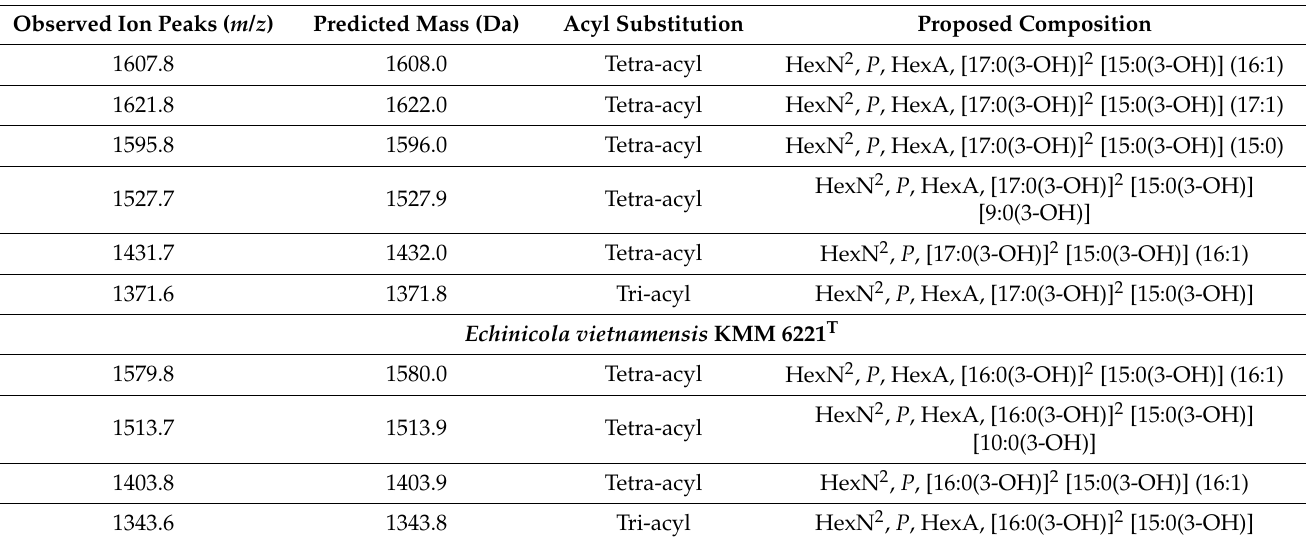
Table 2. The main ion peaks observed in the MALDI-TOF MS spectra reported in Figure 1, the predicted masses, and the proposed interpretation of the substituting fatty acids, phosphate and HexA, on the lipid A backbone. The observed masses reported in the table are compared to the calculated monoisotopic mass (predicted mass, Da) of each ion based on the proposed lipid A